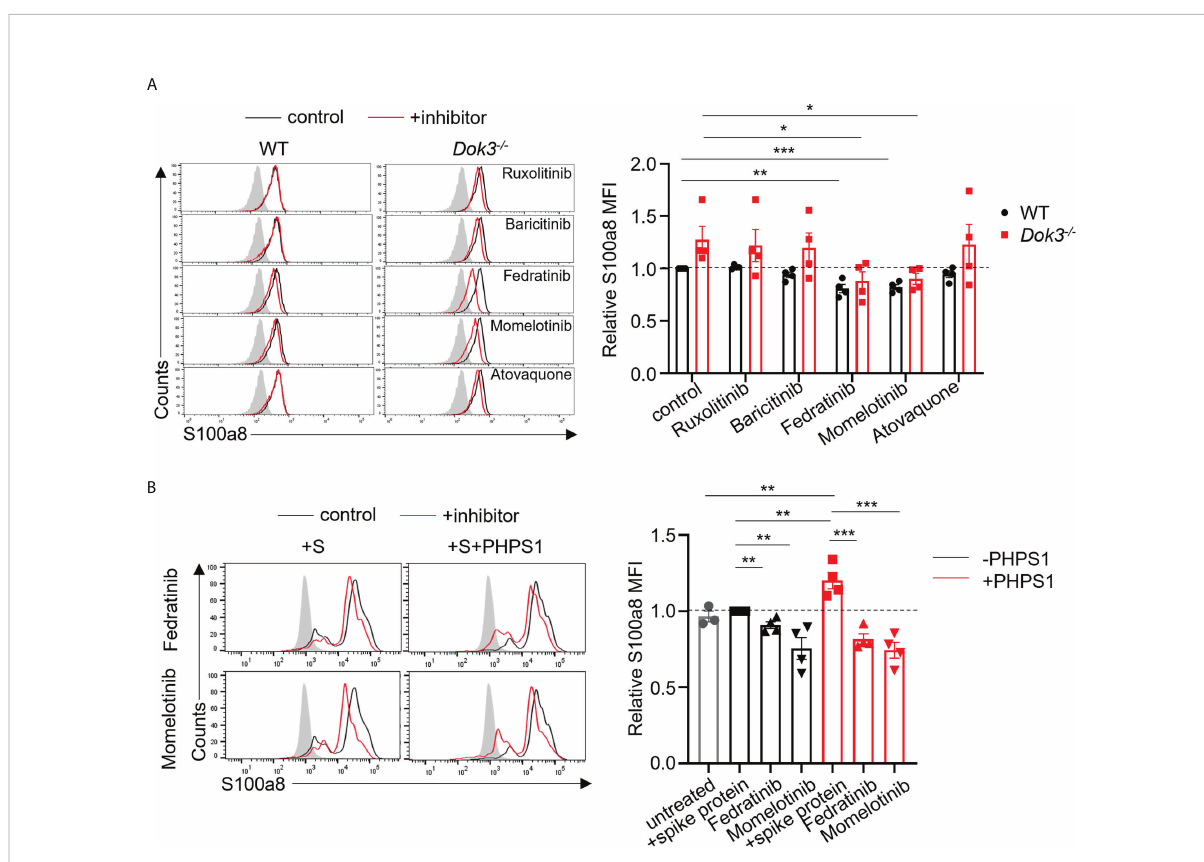
FIGURE 4 Fedratinib and Momelotinib suppress S100a8 expression in mouse and human neutrophils. (A) Flow cytometric analysis of S100a8 expression in WT and Dok3 -/- neutrophils following 3h stimulation with S protein in the presence or absence of indicated inhibitors. Histograms were pre-gated on singlet, Ly6G + cells. Filled histogram represents isotype control. The same control histogram is shown for different inhibitor treatments. Bar graph depicting MFI of S100a8 fl uorescence relative to control WT neutrophils. Data is shown as mean ± S.E.M. (n = 4, 4 independent experiments). *p = 0.04, 0.03, **p = 0.003, ***p = 0.0004, unpaired two-tailed Student ’ s t-test. (B) Flow cytometric analysis of S100a8 expression in puri fi ed human neutrophils following 3h stimulation with S protein in the presence or absence of indicated inhibitors. Filled histogram represents isotype control. The same control histogram is shown for different inhibitor treatments. Bar graph depicting MFI of S100a8 fl uorescence relative to S protein-treated WT neutrophils. Data is shown as mean ± S.E.M. (n = 4, 4 independent experiments). **p = 0.01, 0.006, 0.01, 0.008, ***p = 0.0009, 0.0008, unpaired two-tailed Student ’ s